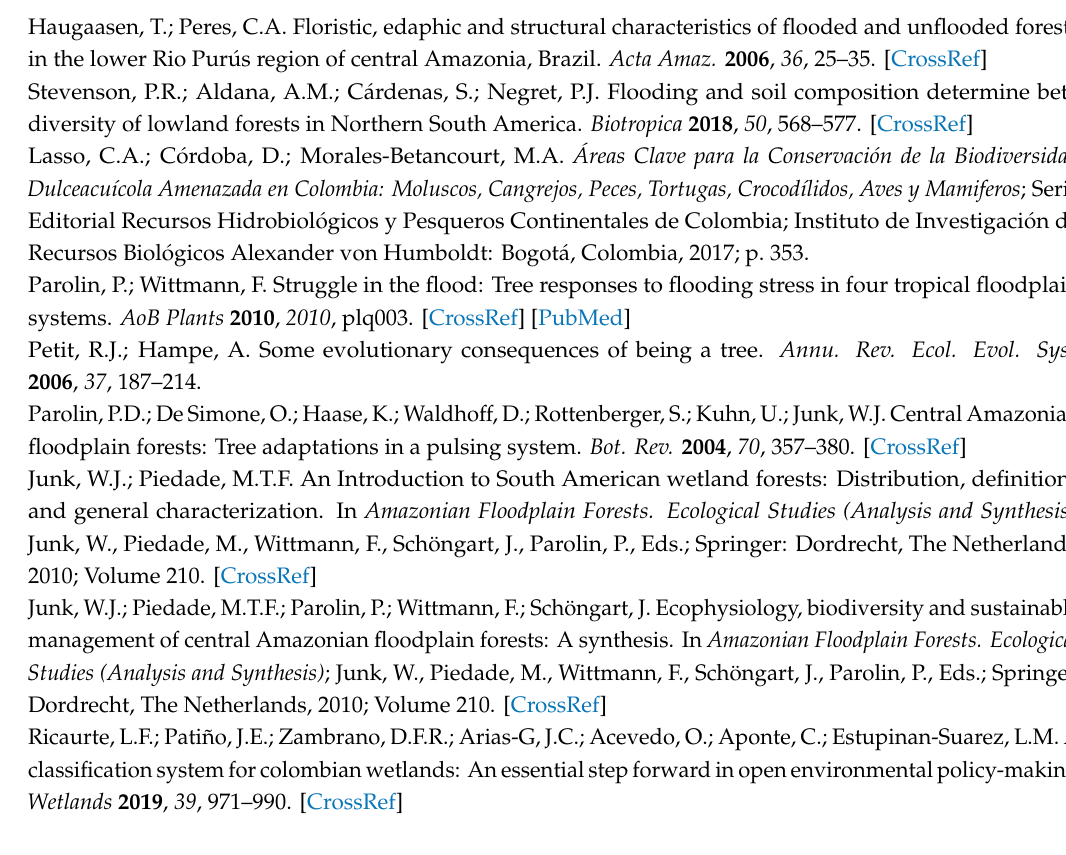
Figure S1: Cluster dendrogram of species based on functional traits, Figure S2: PCA: relationship between functional trait values and species, Table S1: Species sampled and their relative abundance, Table S2: Description of the plant functional traits sampled, Table S3: Summary of the functional trait values for v á rzea and igap ó , Table S4: p -values of the two unilateral statistical tests performed (lower and upper limit) to compare the T statistics with the random expectations, according to each functional trait and forest